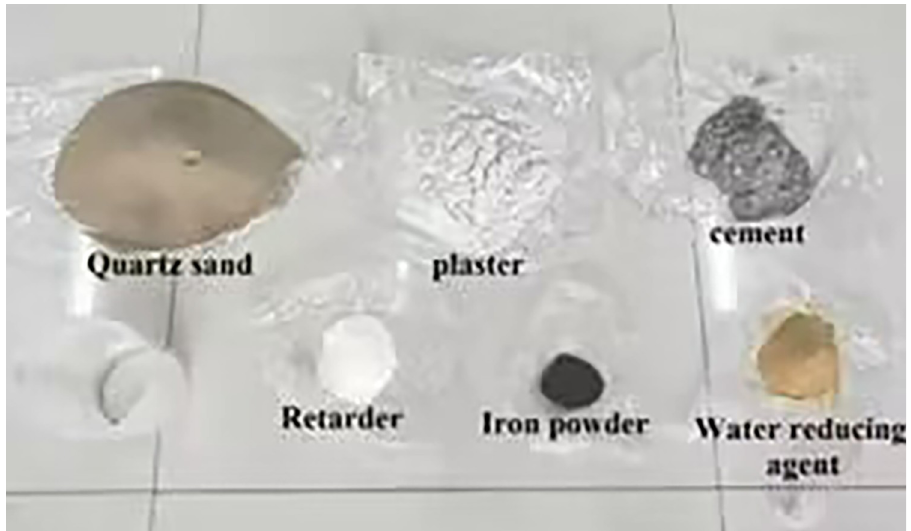
Fig 8. Similar material model of the test material covered by the study.